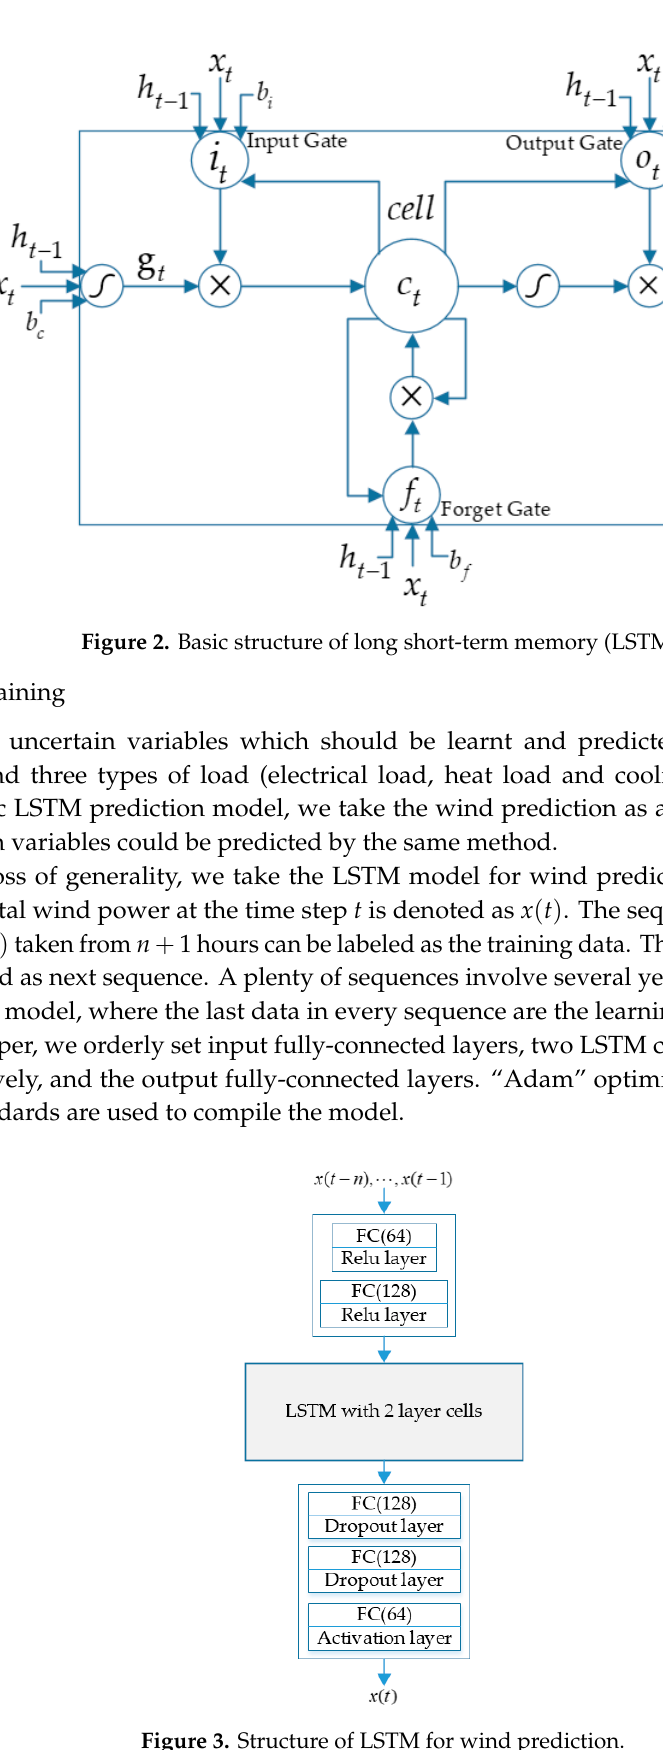
Figure 3. Structure of LSTM for wind prediction.